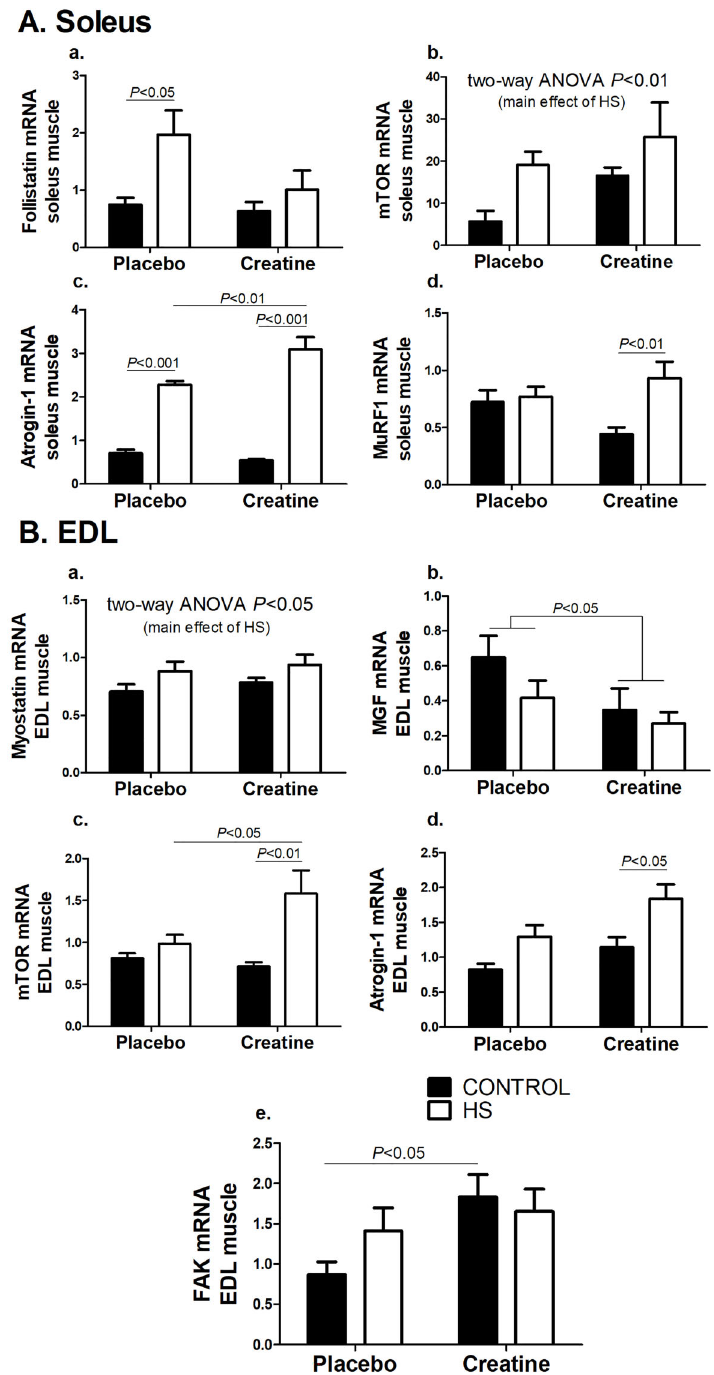
Figure 4. Expression of genes associated with protein synthesis and degradation signaling pathway in the soleus ( A ) muscle and in the EDL ( B ) muscle. Data are reported as means ± SE, n=5 – 6 animals. The results were compared using two-way ANOVA and Bonferroni post hoc test. Ab and Ba are P o 0.05 for C and Cr groups vs C-HS and Cr-HS groups (main effect of HS), using two-way ANOVA only (no statistical differences using the Bonferroni post hoc test). Bb is P o 0.05 for C and HS groups vs Cr and Cr-HS groups (main effect of creatine), using two-way ANOVA only (no statistical differences using the Bonferroni post hoc test). C: control group; HS: hindlimb suspension group; Cr: creatine supplemented group; Cr-HS: creatine supplemented and hindlimb suspension